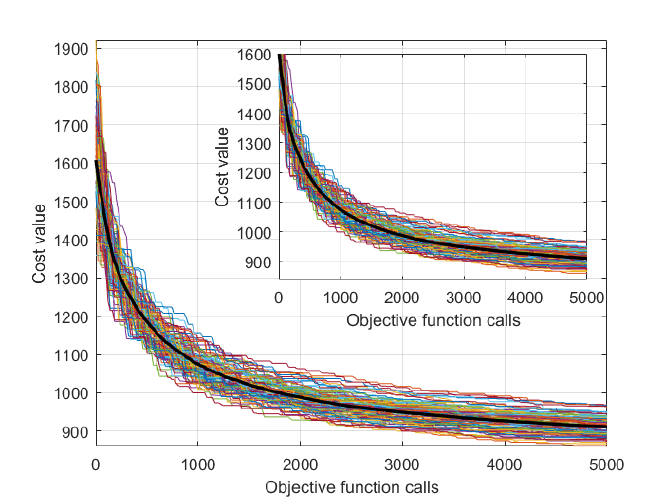
Figure 5. Convergence curves of SNO on 100 independent trials for the unconstrained problem.